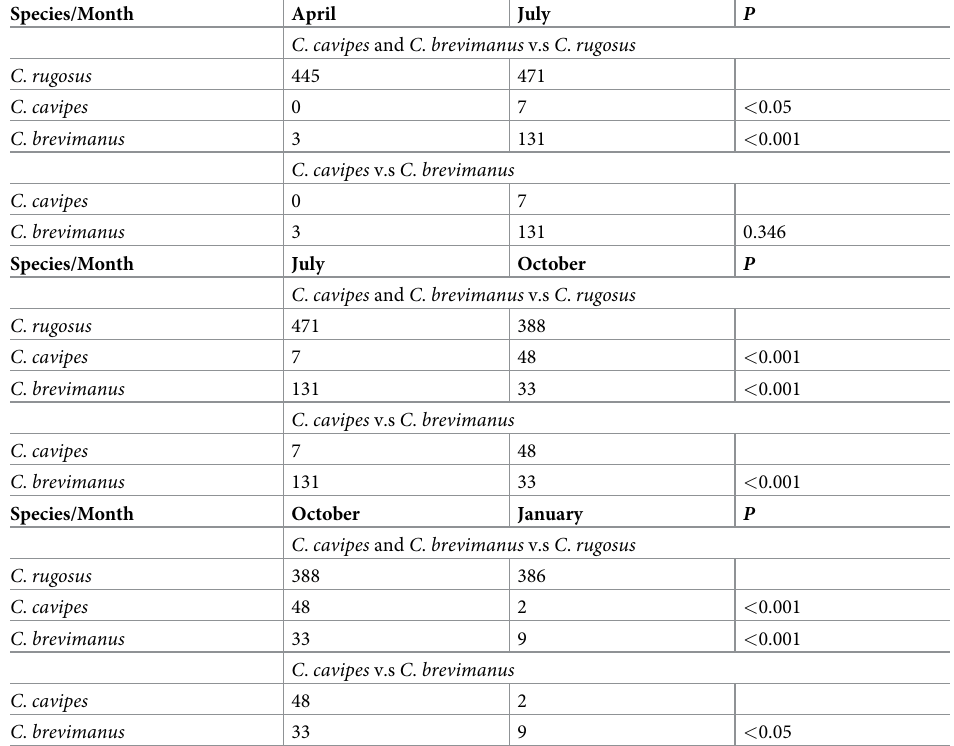
Table 1. Differences between species in the seasonal activity (April, July, October, 2017, and January 2018). P = probability ( χ 2